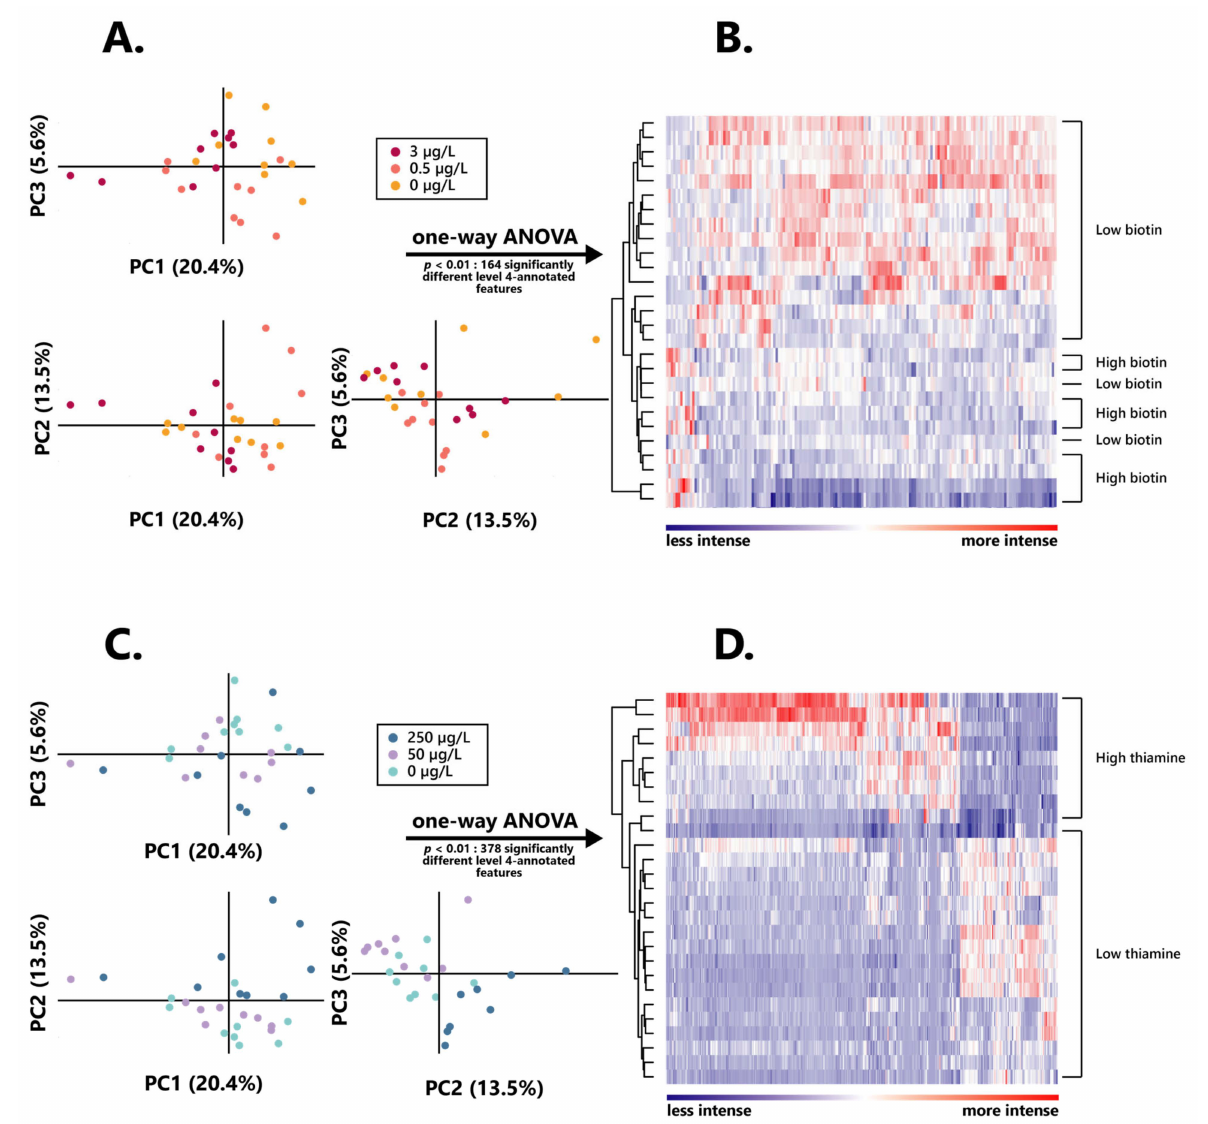
Figure 3. Intensity and distribution of the wine extracted metabolomic features after alcoholic fermentation in varying biotin and thiamine concentrations. ( A ) Principal component analysis individual plot according to the initial biotin content in the growth medium. ( B ) Hierarchical clustered heatmap of the one-way ANOVA significantly different ( p < 0.01) level 4 annotated features between high and low biotin fermentation conditions. ( C ) Principal component analysis individual plot according to the initial thiamine content in the growth medium. ( D ) Hierarchical clustered heatmap of the one-way ANOVA significantly different ( p < 0.01) level 4 annotated features between high and low thiamine fermentation